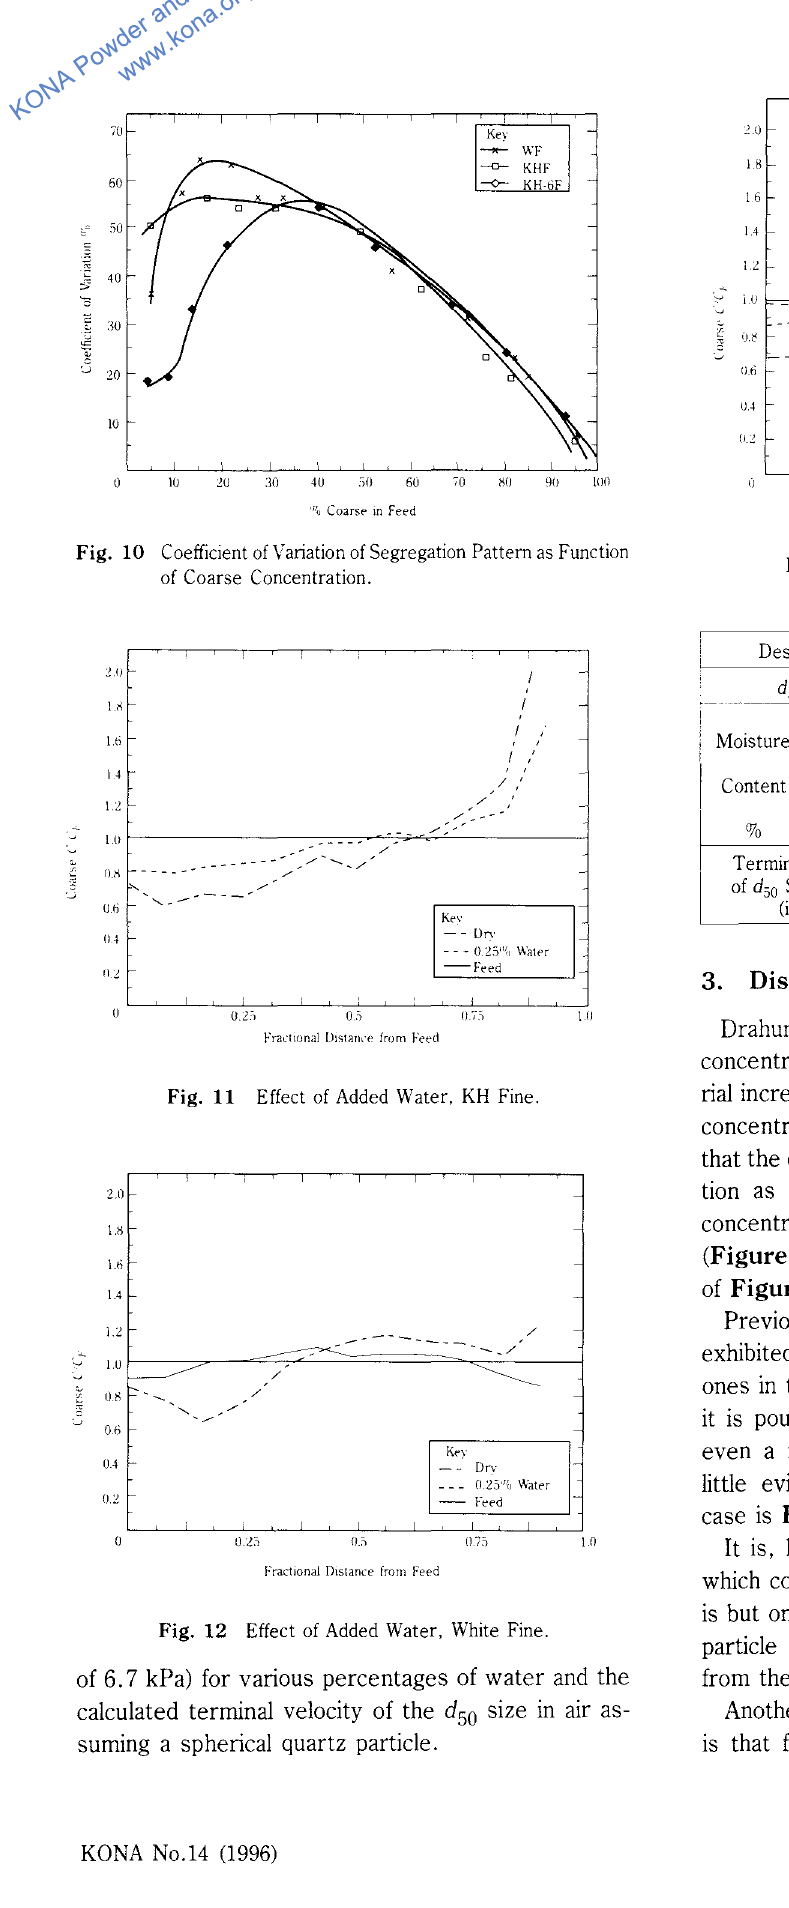
Fig. 12 Effect of Added Water, White Fine.